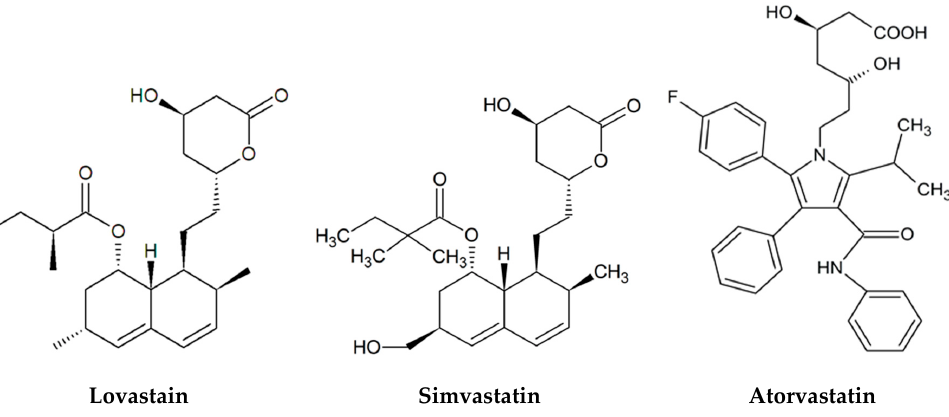
Figure 1. Structure of a natural, semi-synthetic and totally synthetic statin.